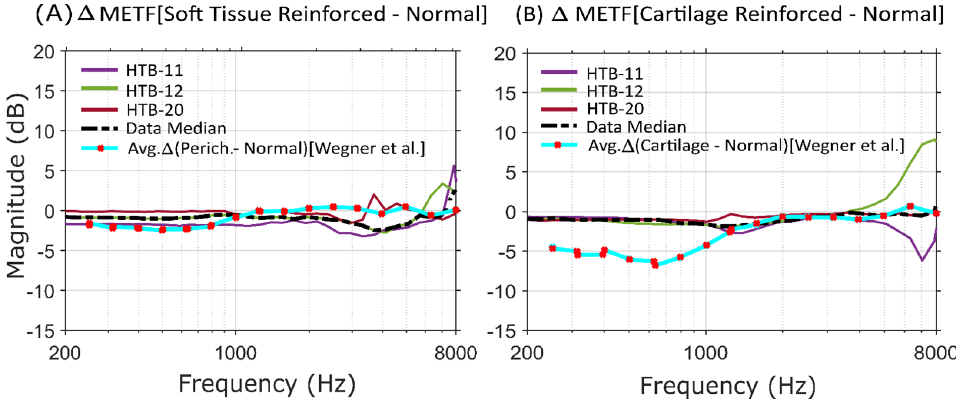
Figure A1. Effect of RWM reinforcement on the METF expressed as the difference between the METF in dB before and after the reinforcement with ( A ) soft tissue and ( B ) cartilage. The thick dashed-dotted lines represent the corresponding median values. The solid lines with circular markers indicate the reference data extracted from Wegner et al. for perichondrium ( n = 9) and cartilage ( n = 4), respectively.